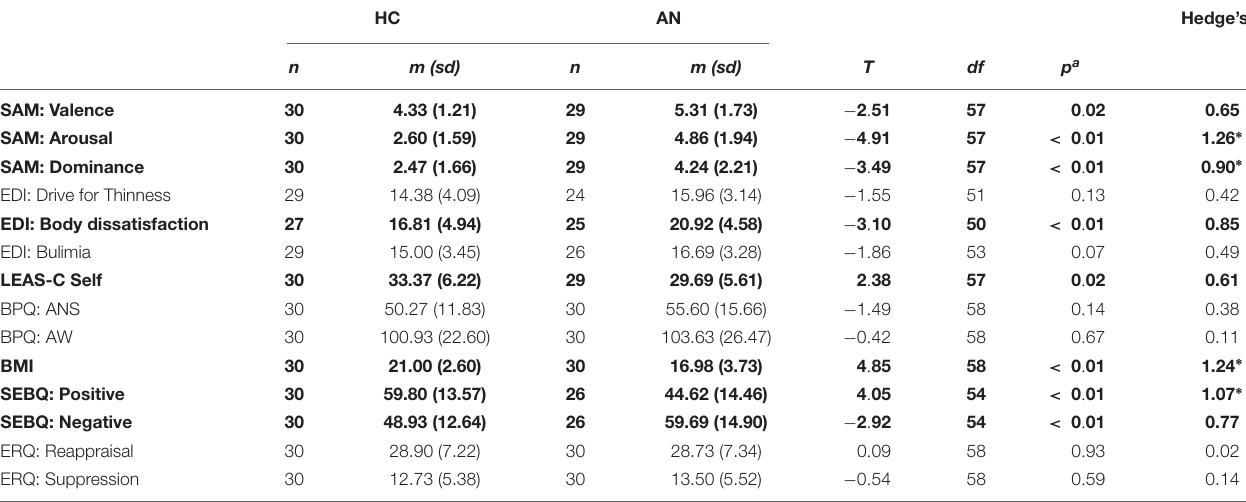
TABLE 2 | Descriptive statistics and mean differences in SAM, EDI, LEAS-C, BPQ, SEBQ, and ERQ scores and BMI between AN patients and matched HCs (no Type I error correction applied). HC AN Hedge’s g